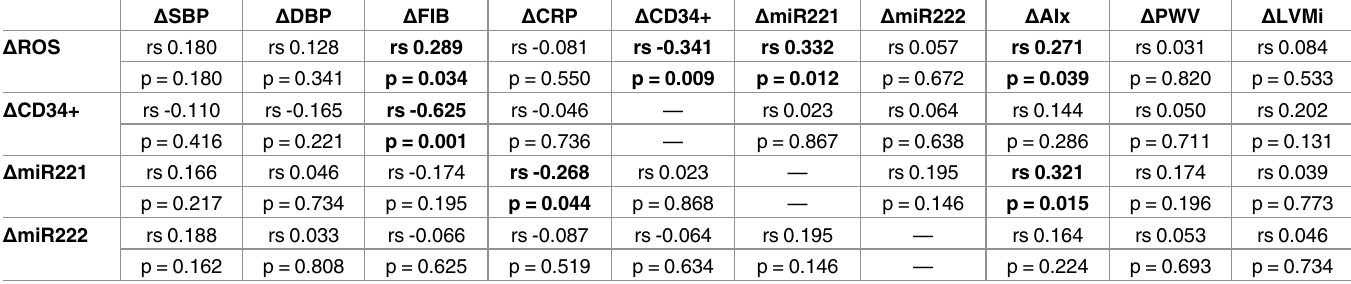
Table 3. Correlations among variables.